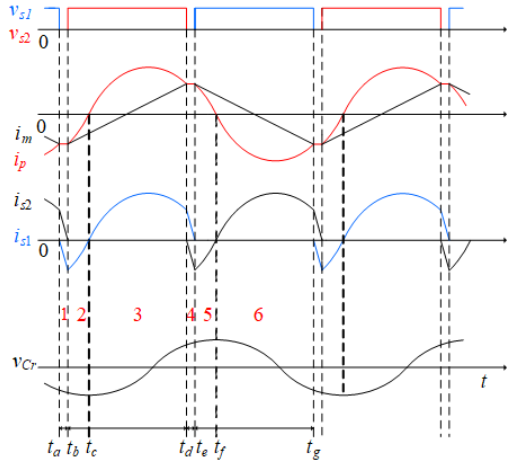
Figure 5. Theoretical